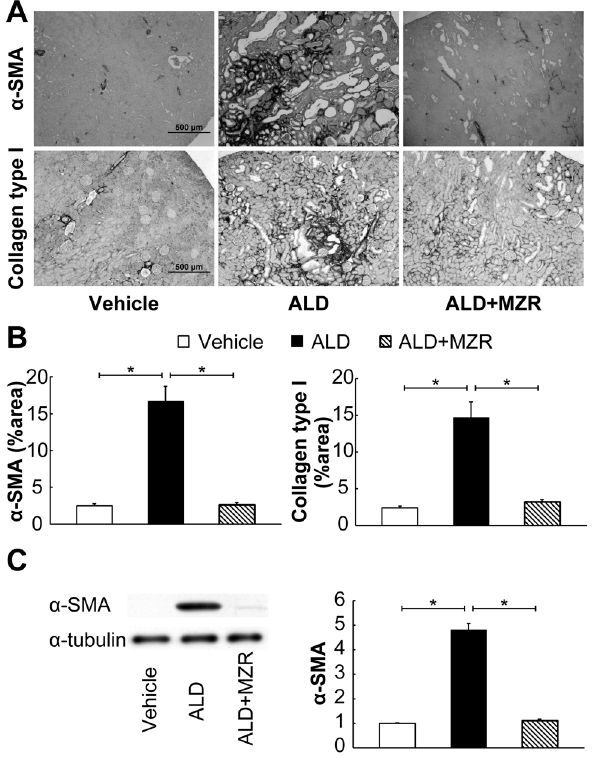
Figure 7. Mizoribine attenuates aldosterone-induced renal fibrosis. Aldosterone (ALD) increased the renal expression of collagen type I and a -smooth muscle actin ( a -SMA), whereas mizoribine (MZR) significantly suppressed the expression. (A) Representative photomi- crographs of collagen type I- and a -SMA-positive areas of the kidney section. (B) Graphs show the collagen type I- and a -SMA-positive percent areas. (C) Western blot analysis for a -SMA and a -tubulin was performed. The total cell lysate was prepared from the renal cortex of rats. Graphs show the expression level quantified by densitometry and normalized with a -tubulin. Values are presented as mean 6 SEM. * P , 0.05.